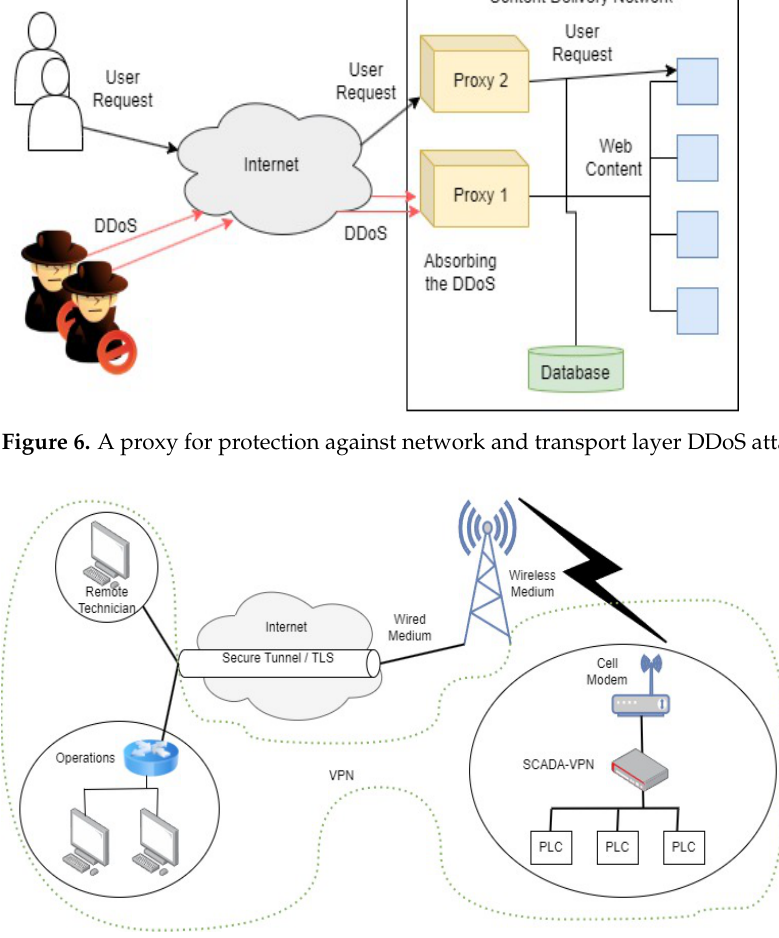
Figure 7. Securing communications (against MITM and FDIA) for SCADA with a